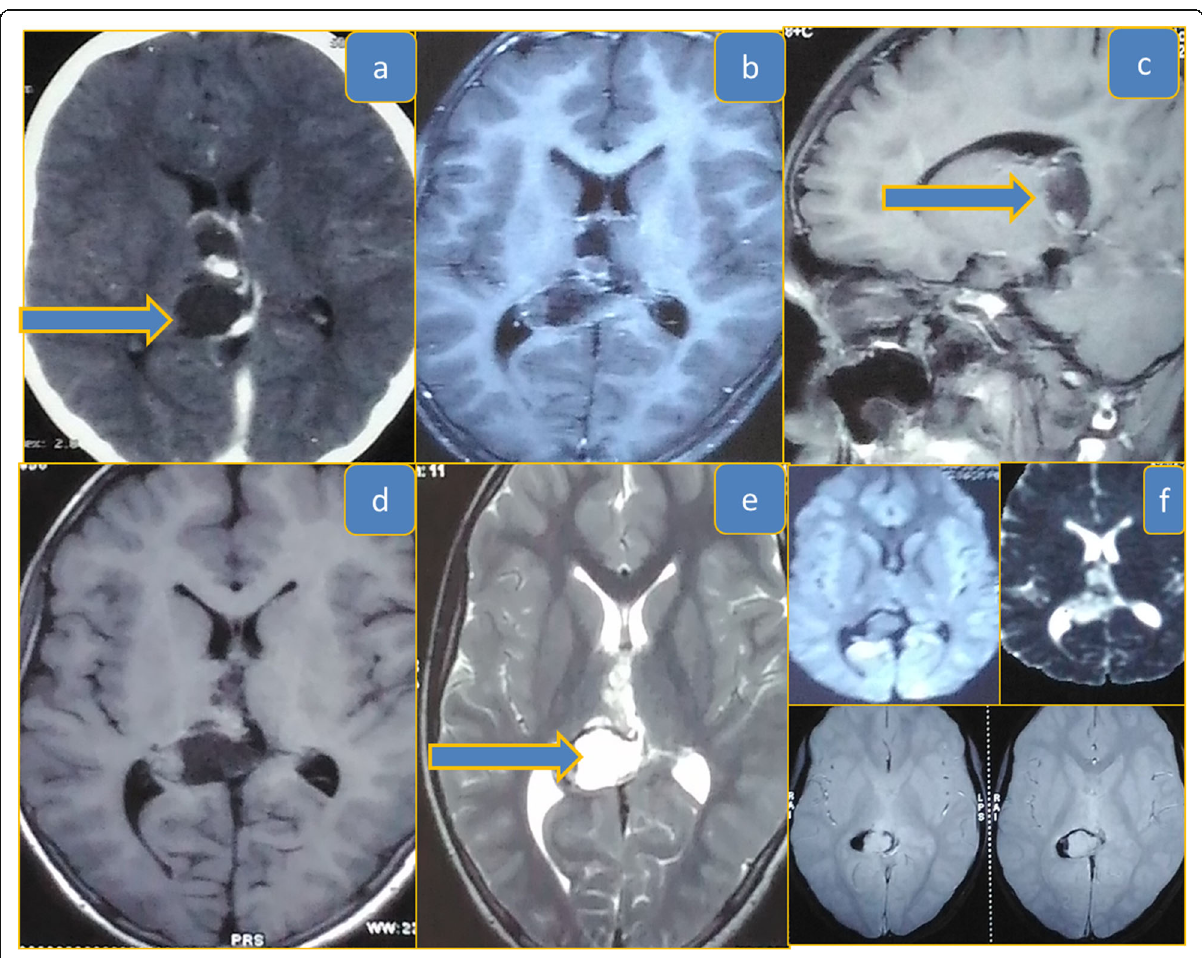
Fig. 1 a CECT head (axial) showing enhancing cystic mass at the posterior 3rd ventricle (arrow mark). b , c Contrast T1 (axial) and contrast T1 (sagittal) showing minimally enhancing cystic mass at the posterior 3rd ventricle. d , e T1 axial sequence showing hypointense and T2 axial showing hyperintense. Mass (arrow mark) at the posterior 3rd ventricle. f Axial sections of diffusion-weighted (DWI) and ADC showing no restriction and gradient sequence MRI showing blooming at periphery of the lesion (arrow